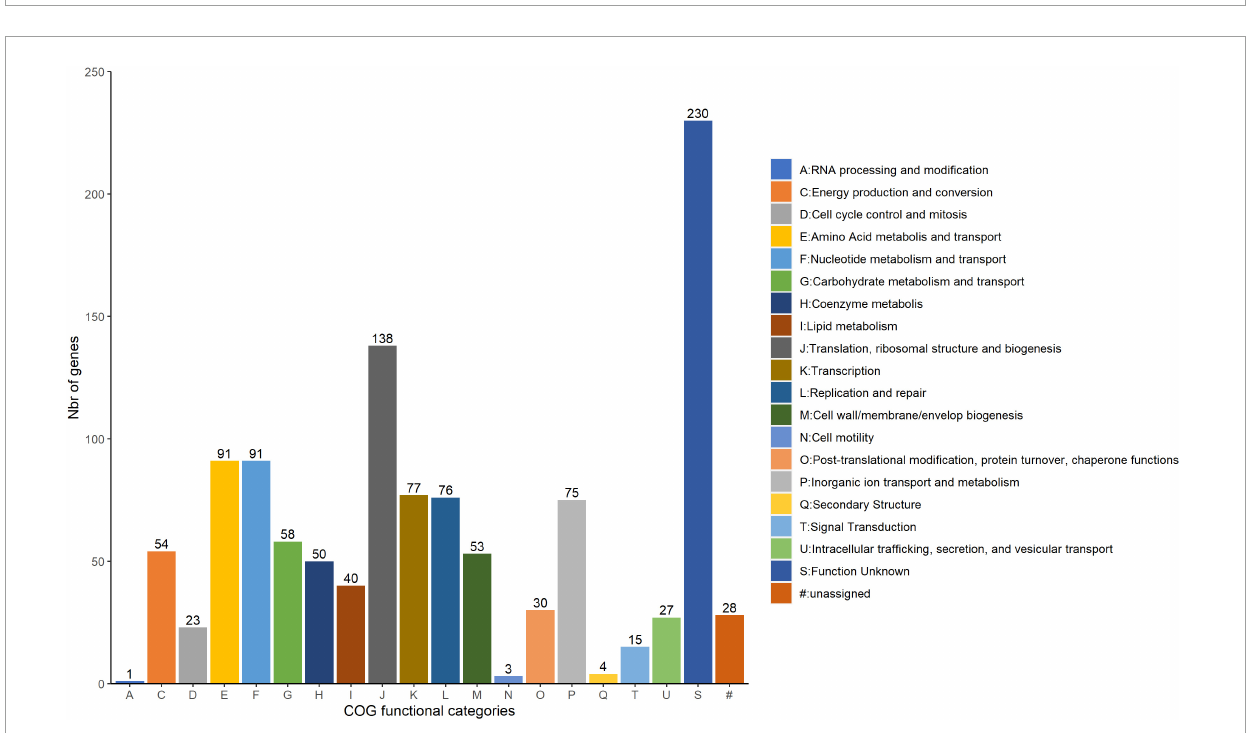
FIGURE3 COG category abundances in the core genome of Weissella paramesenteroides . The number of genes within each category is indicated above the bar of each category abbreviation.